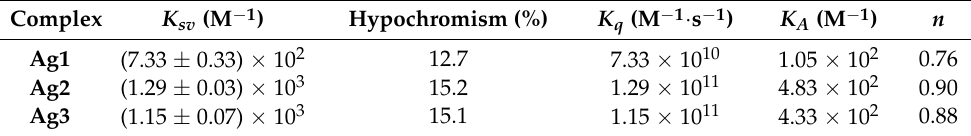
Table 6. Values of the binding constants of complexes Ag1 – Ag3 with ct-DNA.